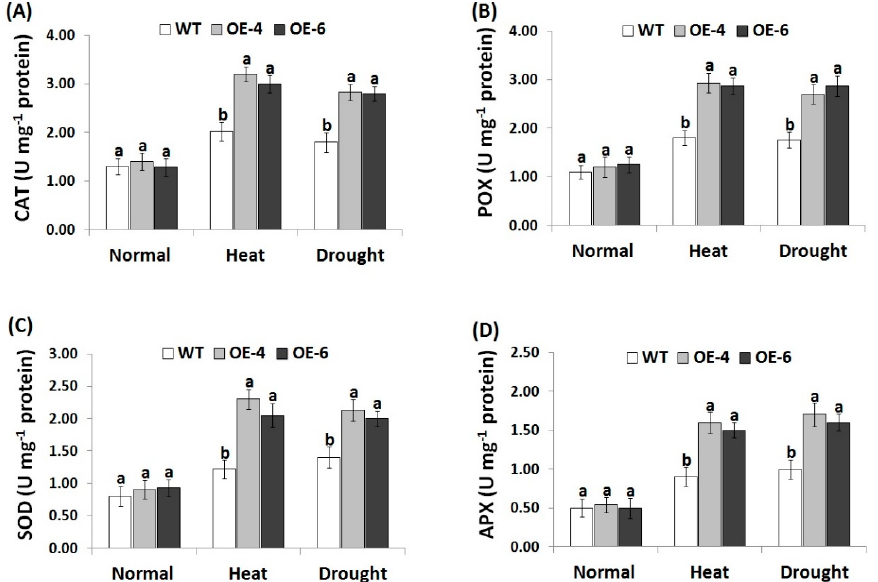
Figure 5. Activity of catalase (CAT) ( A ), peroxidase (POX) ( B ), superoxide dismutase (SOD) ( C ), and ascorbate peroxidase (APX) ( D ) in wild type and transgenic wheat lines under normal, heat, and drought stress treatments. Data indicate means ± SE ( n = 4). Different letters above columns represent significant difference ( p ≤ 0.05).